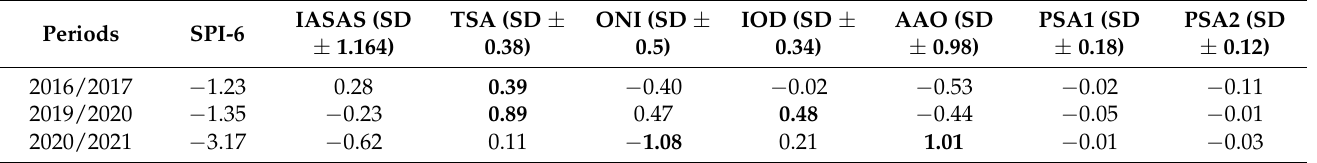
Figure 8. SST anomaly considering the subtraction of the Oct–Mar average, within the hydrological drought event, from the Oct–Mar climatology (1979–2021). This field was plotted for 2016/2017, Table 6. Values of the March SPI-6, and the average of the monthly values of the IASAS, TSA, ONI, IOD, AAO, PSA1, and PSA2 indices for the Oct–Mar periods classified as moderate, severe, or extreme dry conditions (identified by the SPI-6), during the hydrological drought event (identified by SPI-12) for the PHR. The standard deviation (SD) of the indices was obtained from the website: https://meteorologia.unifei.edu.br/teleconexoes/ (accessed on 21 March 2022). The indices that surpass the SD are highlighted in bold.